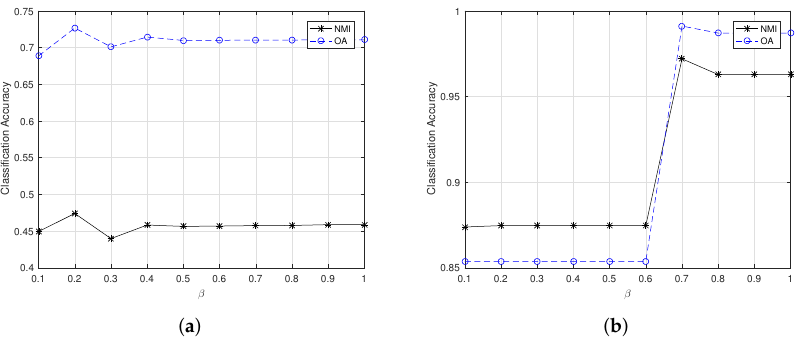
Figure 3. The change of clustering OA and NMI for small-scale HSI datasets yielded by PCSSCAG with different β . ( a ) The Indian Pine dataset, ( b ) the Salinas-A dataset. (2) Parameter analysis for the large-scale HSIs The changes of clustering OA and NMI for the large-scale HSI datasets are exhibited in Figures 4 and 5. It can be learned that the most appropriate value of β for the University of Pavia dataset in CSSCAG and PCSSCAG are 0.7 and 0.6, respectively. For the Salinas